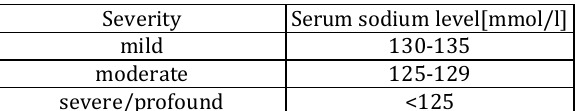
Table 1. Division of hyponatremia according to serum